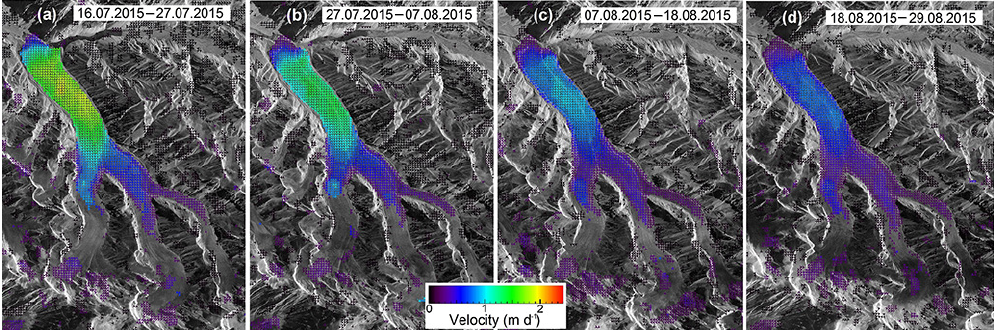
Figure 7. Velocity fields showing (a) the maximum velocity reached in 2015, followed by (b) – (d) the sudden deceleration from the end of July into August. These velocity fields were calculated from consecutive 11-day periods. Background image from TanDEM-X data provided by the German Space Agency